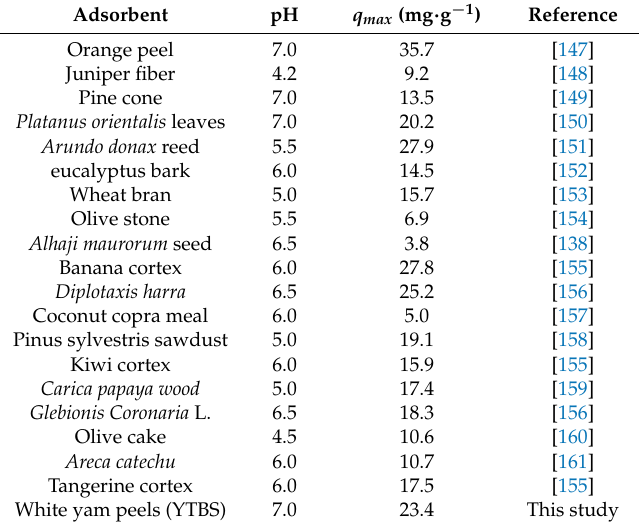
Table 7. Cd(II) Langmuir constant q max of this study with those reported in